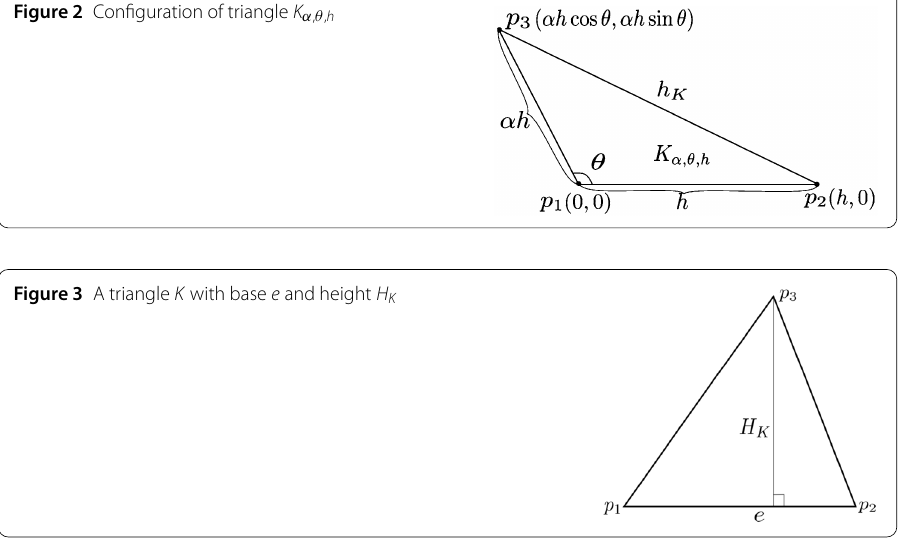
Figure 2 Configuration of triangle K α , θ , h